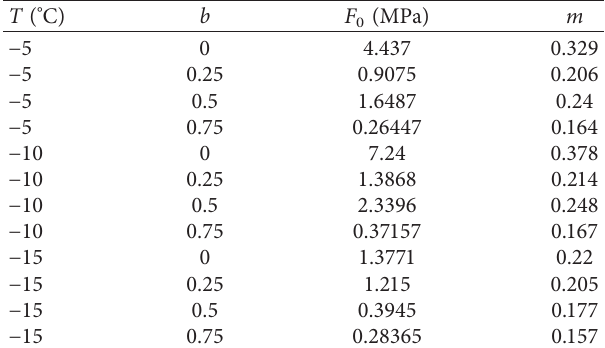
Table 1: Fitting results of the Weibull parameters at different temperatures and medium principal stress